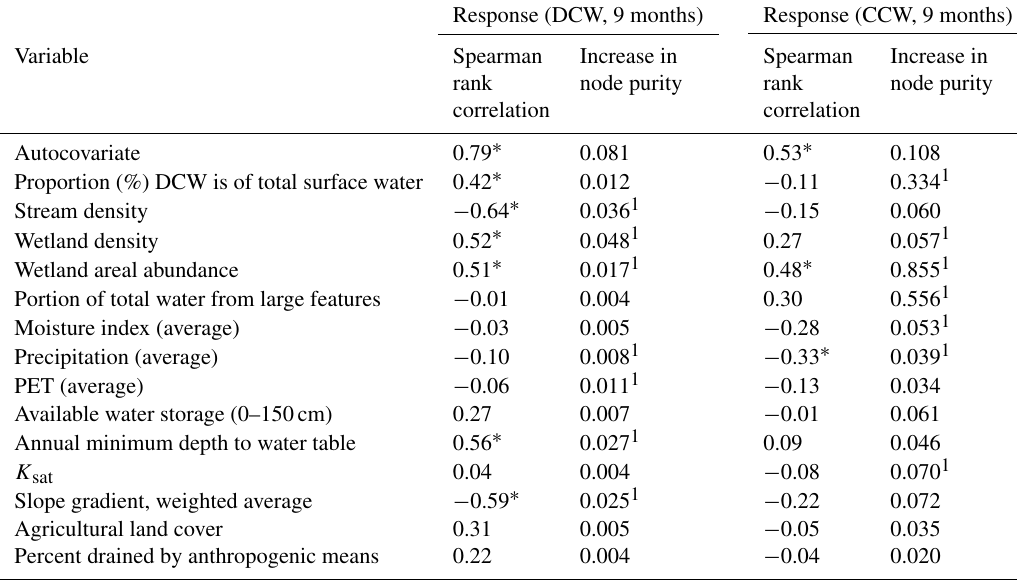
Table 7. Spearman rank correlation values between the dependent variables and each of the independent variables considered in the analysis. Bonferroni correction was applied to the p values and significant correlations ( p < 0.05) are starred. Relative variable importance as deter- mined by random forest models are also presented for each variable (i.e., increase in node purity). PET – potential evapotranspiration, K sat – saturated hydraulic conductivity, DCW – disconnected surface water, and CCW – continuously, connected surface